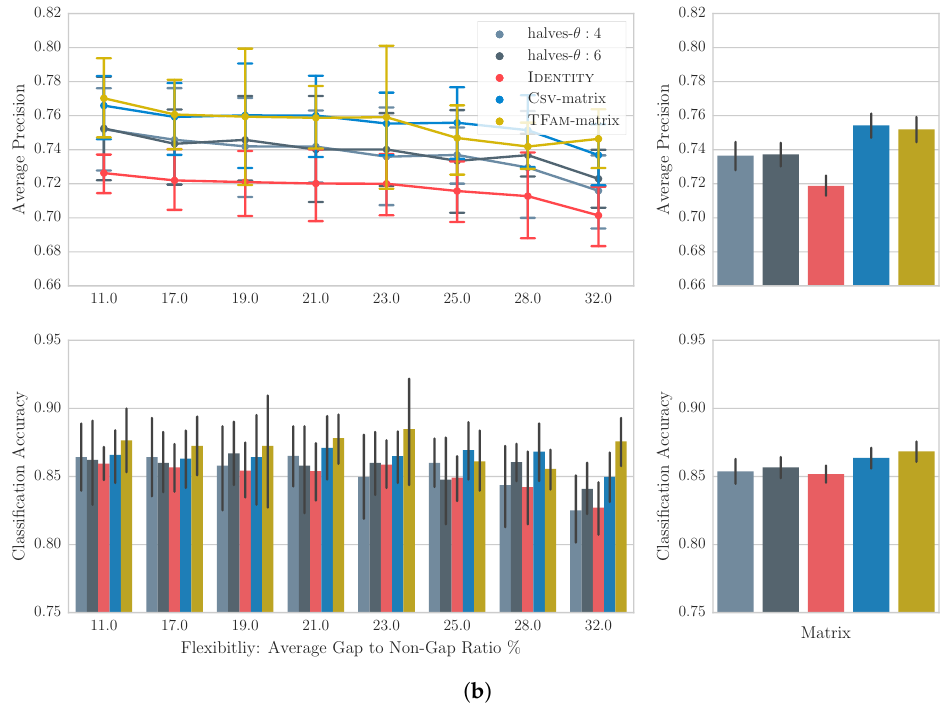
Figure 8. Average precision and classification accuracy for each matrix over a range of flexibility values (left) for the T UNE F AM -26 ( a ) and C SV -60 ( b ) datasets. The average precision and accuracy over all flexibilities per matrix are also presented on the